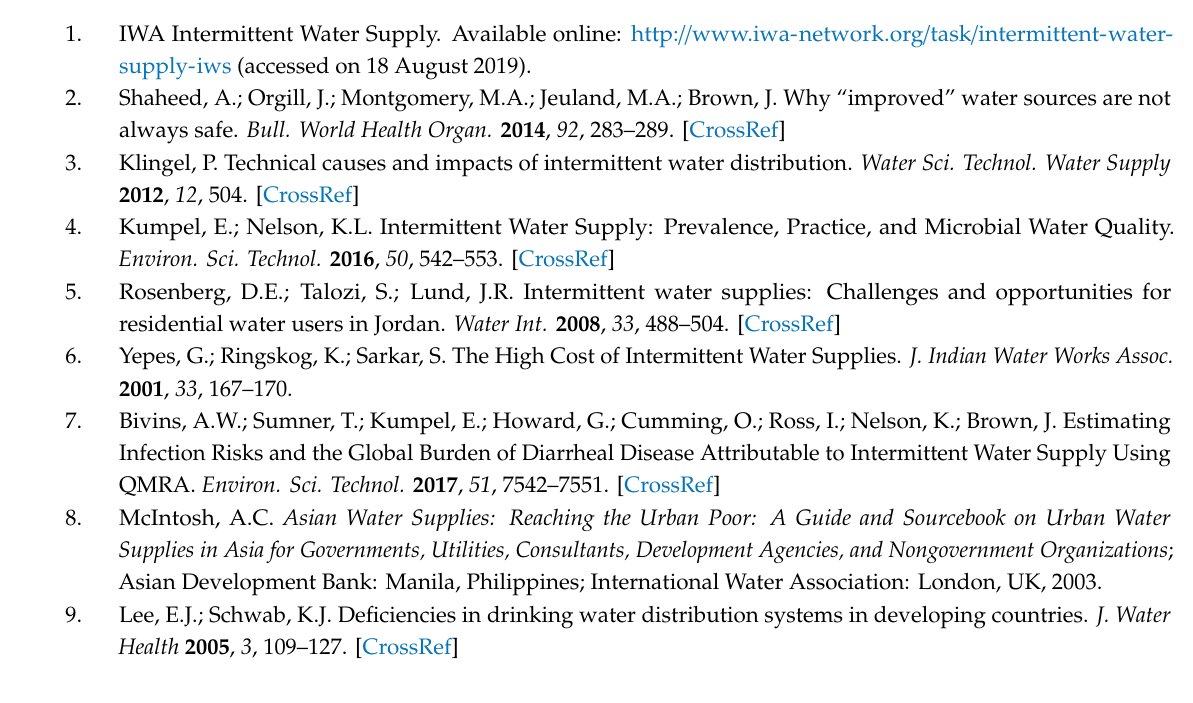
Figure S1: Location of the study zones and upstream monitoring points, Figure S2: Schematic of Study Zone 1, Figure S3: Schematic of Study Zone 3, Figure S4: Schematic of Study Zone 4, Figure S5: Pressure transient at 3:30 a.m. 18 November 2014 at the discharge of the Zone 4 pump station caused by the startup of the second of two pumps, Table S1: The ten zones with the highest break